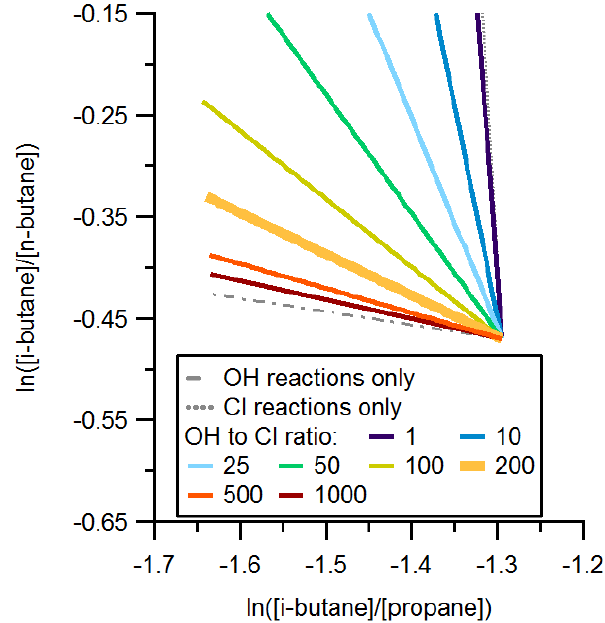
Fig. 3. Evolution of one set of VOC tracer ratios ( i -butane, n - butane, and propane) under different ratios of [OH] to [Cl] (Con- dition Set 1) in the absence of NO x . The total radical concentration was held at 5 × 10 6 moleculescm − 3 and photochemical processing was allowed to proceed for